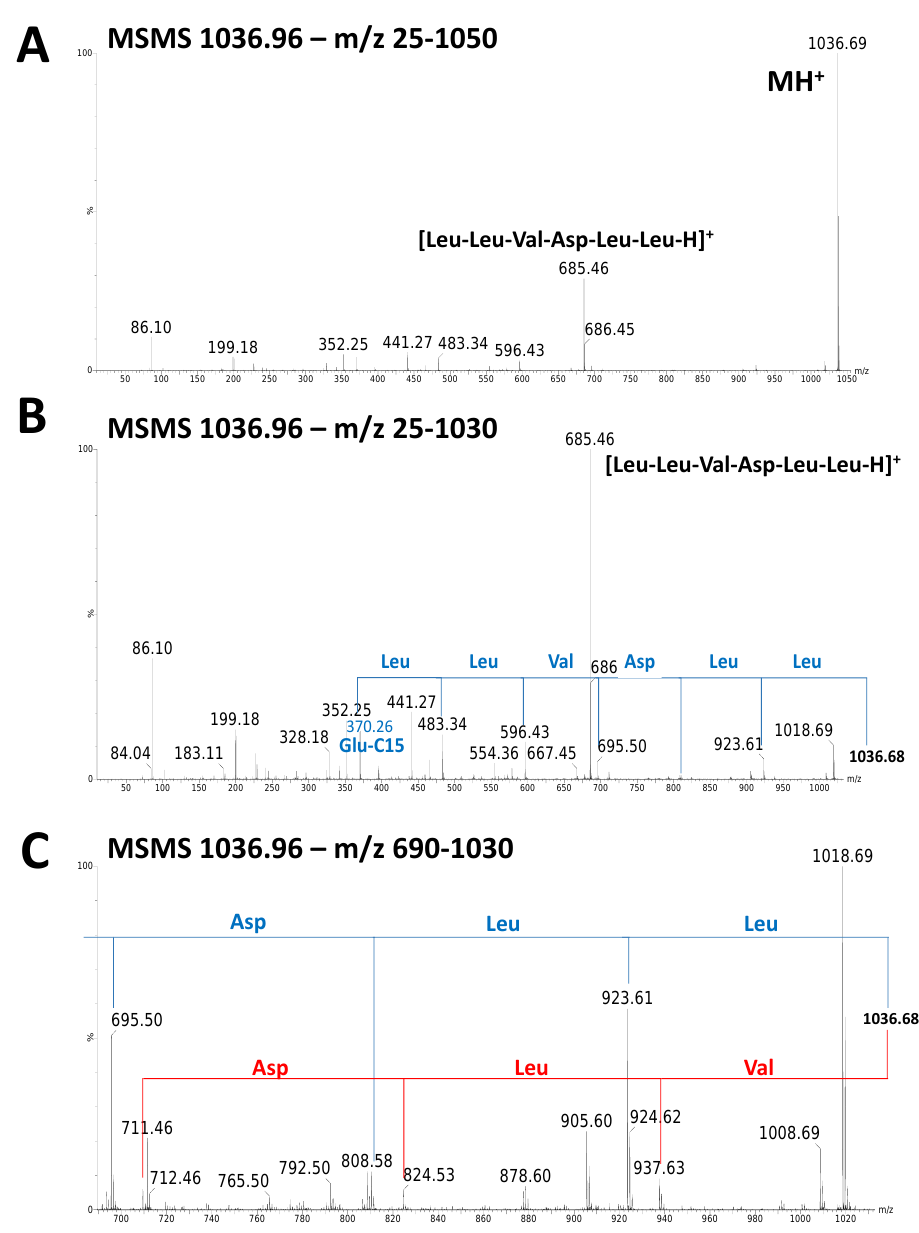
Figure 6. Fragmentation spectra of ion m / z 1036.96 from LC-HRMS analysis of supernatant sample of B. subtilis (strain 23) after 48 h culture. ( A ) corresponds to the full MSMS spectrum, ( B ) to the MSMS spectrum enlarged to the m / z range 25–1030, and ( C ) to the MSMS spectrum enlarged to the m / z range 690–1030. The fragmentation proposals for surfactin A C15 and B C16 are presented in blue and red,